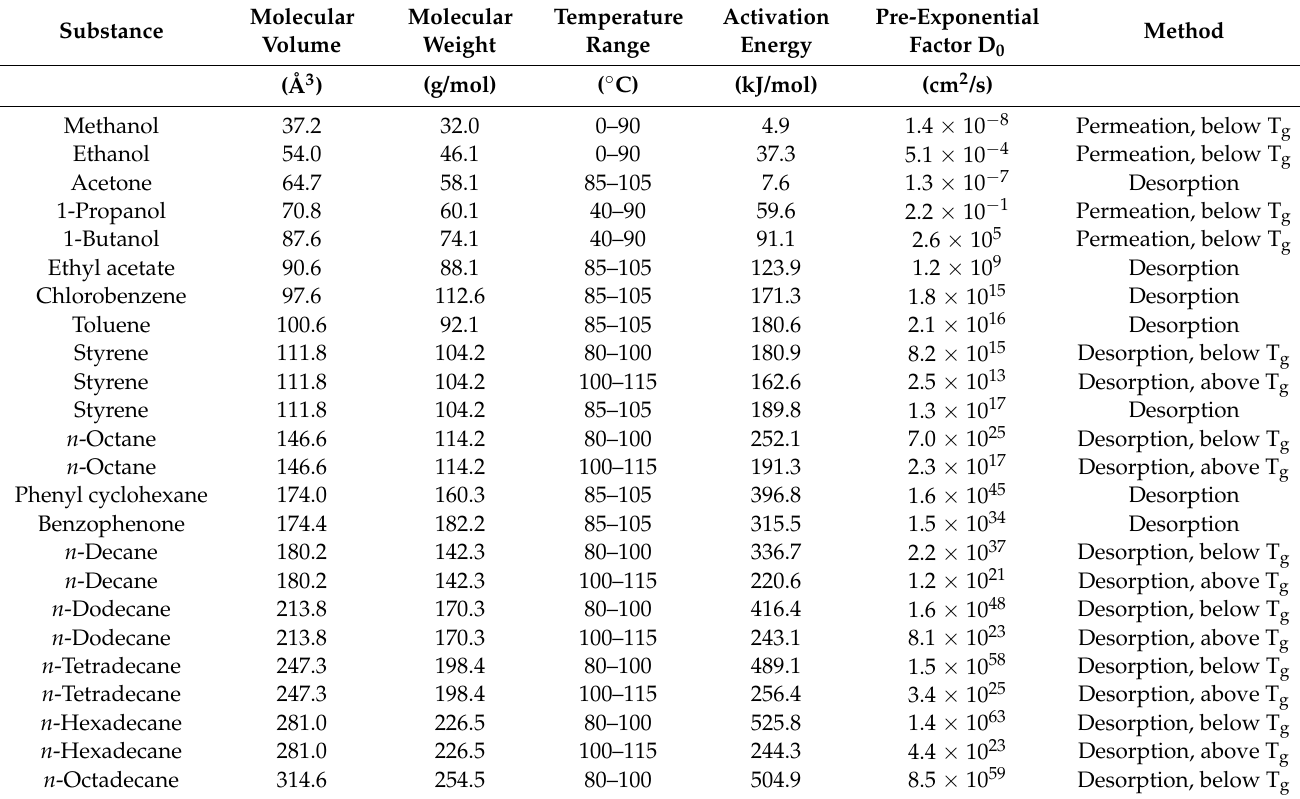
Table 6. Activation energies of diffusion E A and pre-exponential factors D 0 for GPPS.